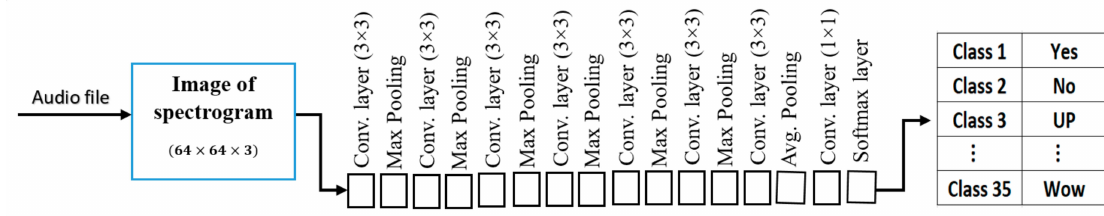
Figure 7. Darknet-Reference architecture.